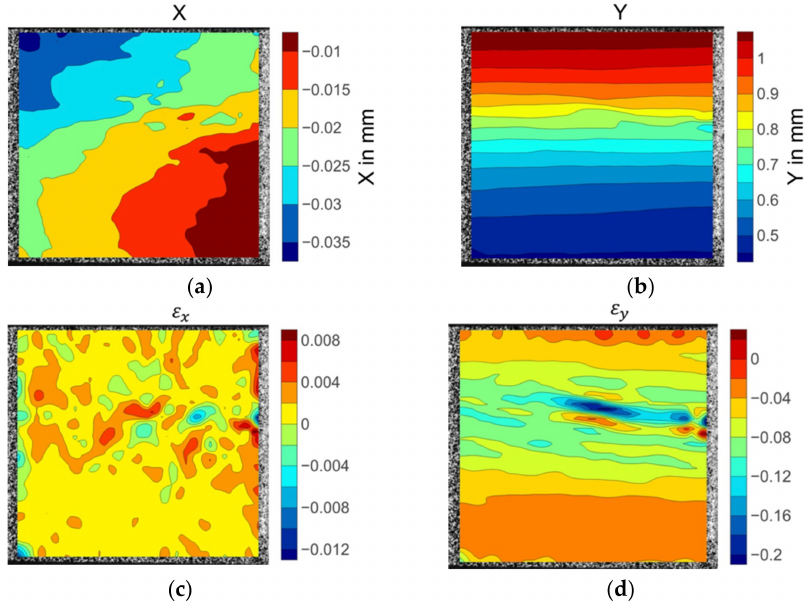
Figure 13. The displacement and strain field contour plots of the 75 ◦ off-axis specimen: ( a )displacement in X direction; ( b ) displacement in Y direction; ( c ) strain in X direction; ( d ) strain in Y direction. The displacement and strain fields of the 90 ◦ on-axis transverse compression specimen is shown in Figure 14. The specimen exhibited a consistent displacement arrangement. Apparent strain concentrations of ε y appeared in accordance with the final fracture site. Cracks originated from these peaks of strain values to form the fracture surface.